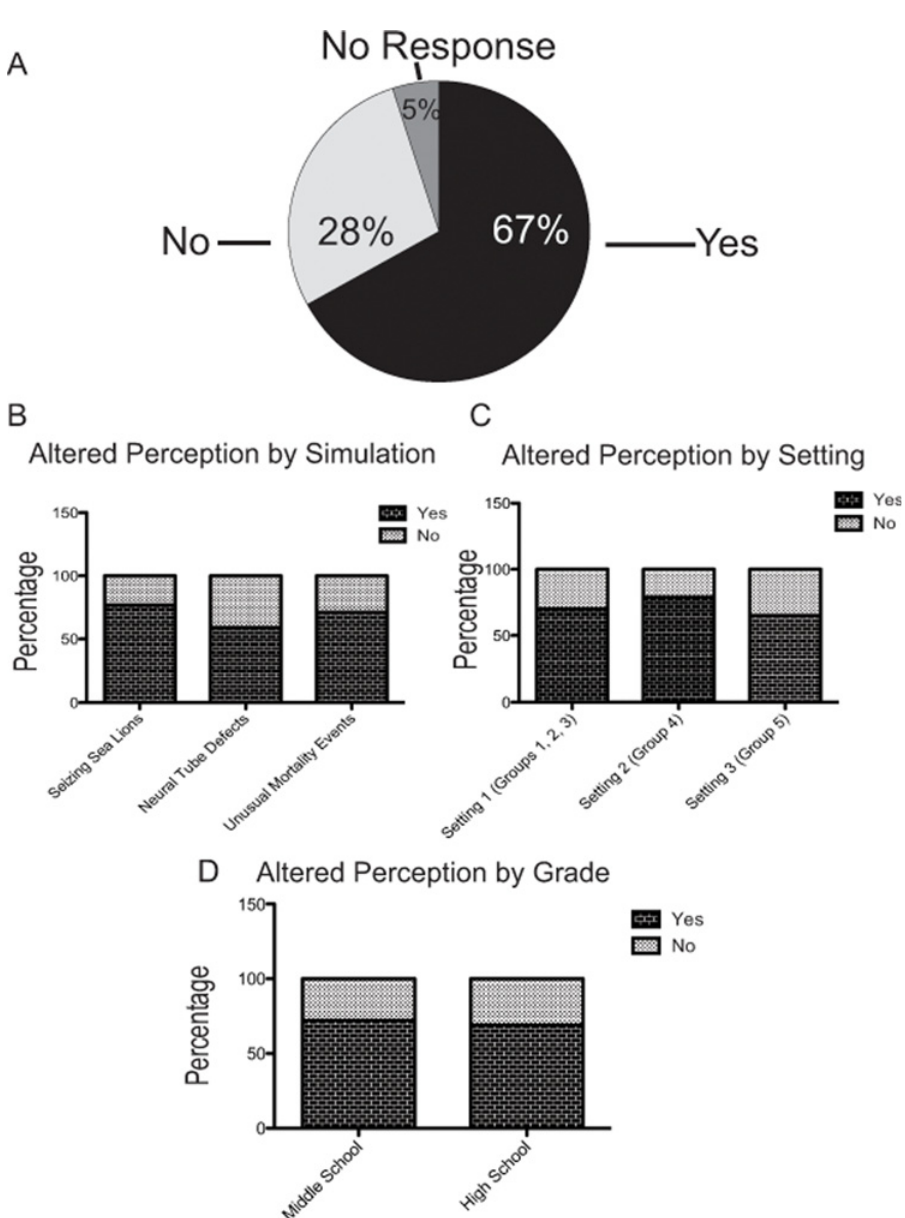
Fig 3. SCI simulations are effective at changing student ’ s perceptions of authentic science practices. (A) Of the 88 students who used the SCI simulations, 67% reported that use of the simulation altered their perceptions of the nature of authentic science practices. 28% of students indicated no change in perception of authentic science practices and 5% of students did not respond and were excluded from additional analyses. (B) All simulations were successful at changing students ’ perceptions of authentic science practices, although no single simulation was more successful in this regard. (C) Regardless of setting, students reported changes in their perceptions of authentic science practices. (D) Grade level had no impact on whether students ’ perceptions of authentic science practices changed, and students of both groups had a higher percentage of yes than no